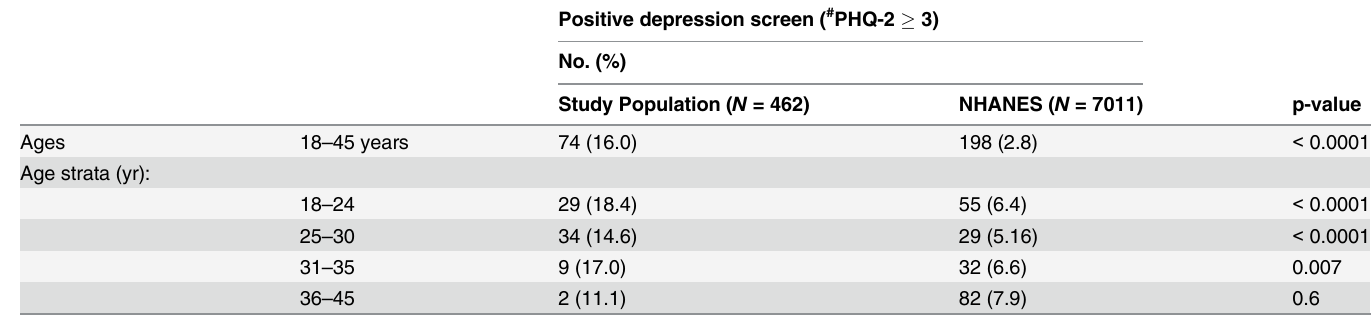
Table 3. Comparison of positive depression screens between study population (years 2013 – 2014) and NHANES population (years 2013 – 2014).